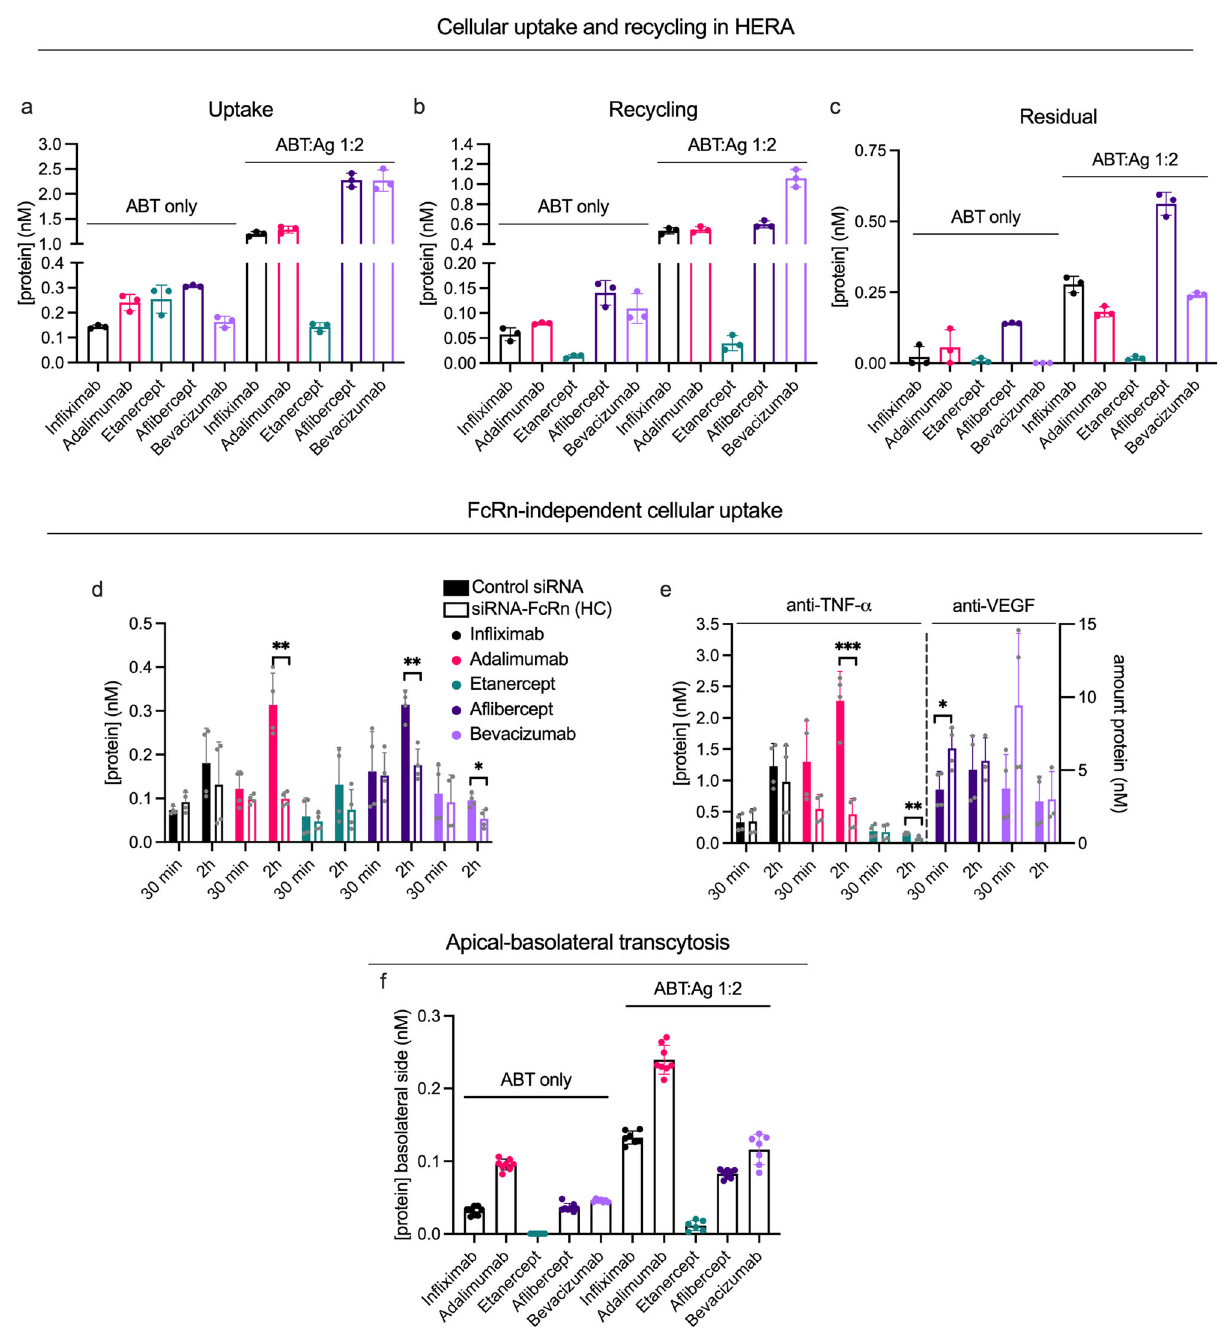
Fig. 6 FcRn-mediated cellular handling differs between ABTs with distinct Fc-fused modalities. a , c , e HERA parameters from one representative experiment, assessing amounts of ABTs as monomers (ABT only) and preincubated with a two-fold molar excess of their cognate Ags at pH 7.4 (ABT:Ag 1:2) taken up ( a ), recycled by ( b ) and kept in ( c ) HMEC-1-FcRn cells ( n = 3 per bar). Two representative experiments showing amount of ABTs, as both monomers ( d ) and after preincubation with two-fold molar excess of cognate Ags ( e ), taken up after incubation for 30 min or 2 h on HMEC-1-FcRn cells treated with control siRNA or siRNA against the HC of FcRn. In e , anti-TNF- α and anti-VEGF ABTs are plotted on the left and right y -axis, respectively, as indicated. Differences between ctrl and siRNA-FcRn-treated cells for each sample group are indicated (* p < 0.05, ** p < 0.005, *** p < 0.0005, two-tailed, unpaired Student ’ s t test). n = 4 per bar. f Amount of monomeric and Ag-bound ABTs on the basolateral side of polarized MDCK-hFcRn cells following apical application and an incubation of 4 h. Values correspond to two independent experiments ( n = 8 per bar). Color labeling; in fl iximab (black), adalimumab (pink), etanercept (teal), a fl ibercept (dark purple), bevacizumab (light purple). Data show mean values ±